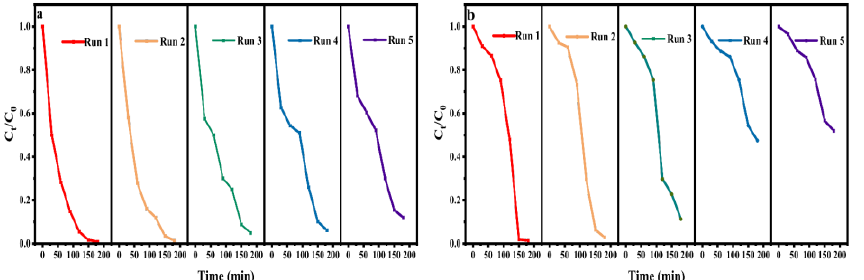
Figure 7. ( a ) Reusability test on the CaWO 4 degrades MB system, and ( b ) Reusability test on the CaWO 4 degrades CR system. Reaction conditions: light intensity = 80 W; [MB] = 100 mg/L; and pH = 8.2; [CaWO 4 ] = 1.0 g/L for ( a ) and light intensity = 80 W; [CR] = 100 mg/L; pH = 8.2; and [CaWO 4 ] = 1.0 g/L for (b).